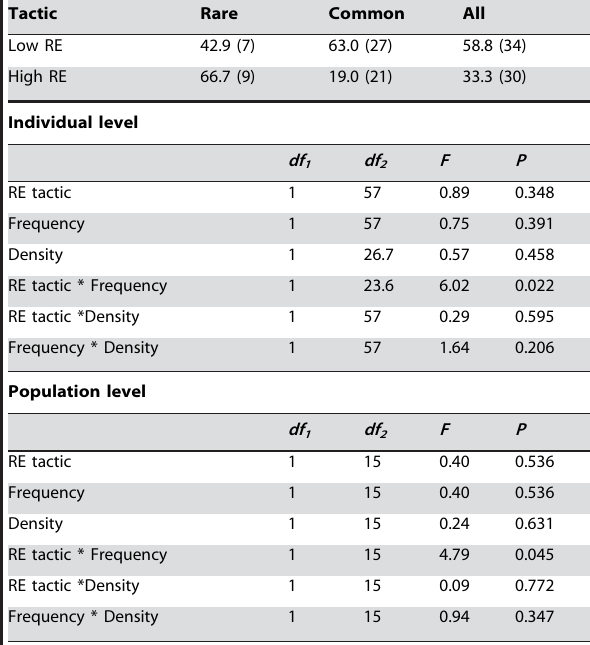
Table 2. Survival differences between the high and low RE females and whether the tactic was rare or common in the